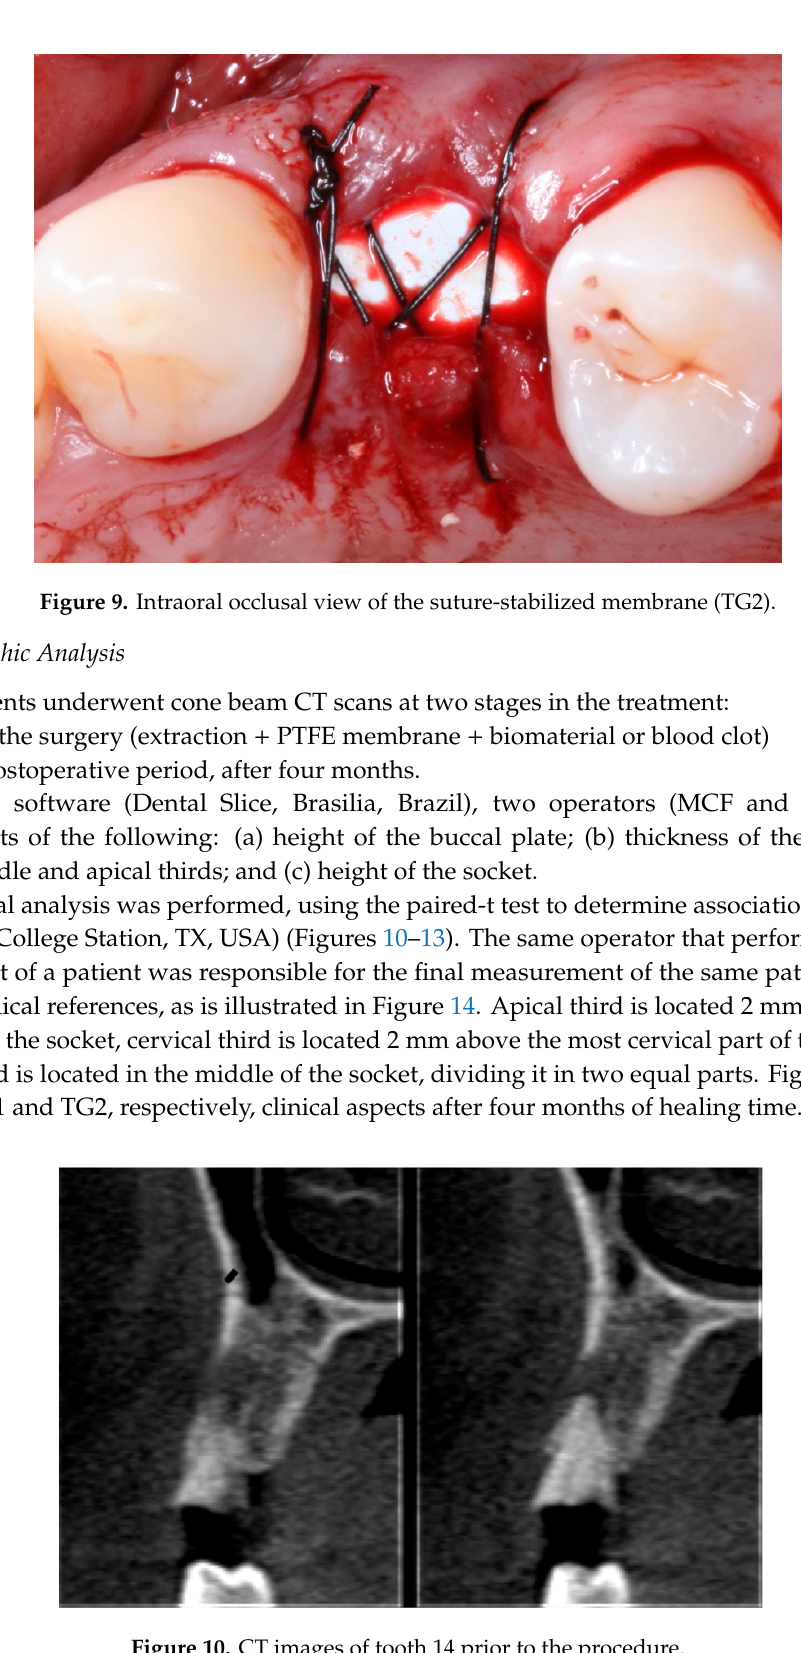
Figure 8. Intraoral occlusal view of the position of the d-PTFE and with the placement of the xenograft biomaterial in the socket of tooth 24 (TG2).